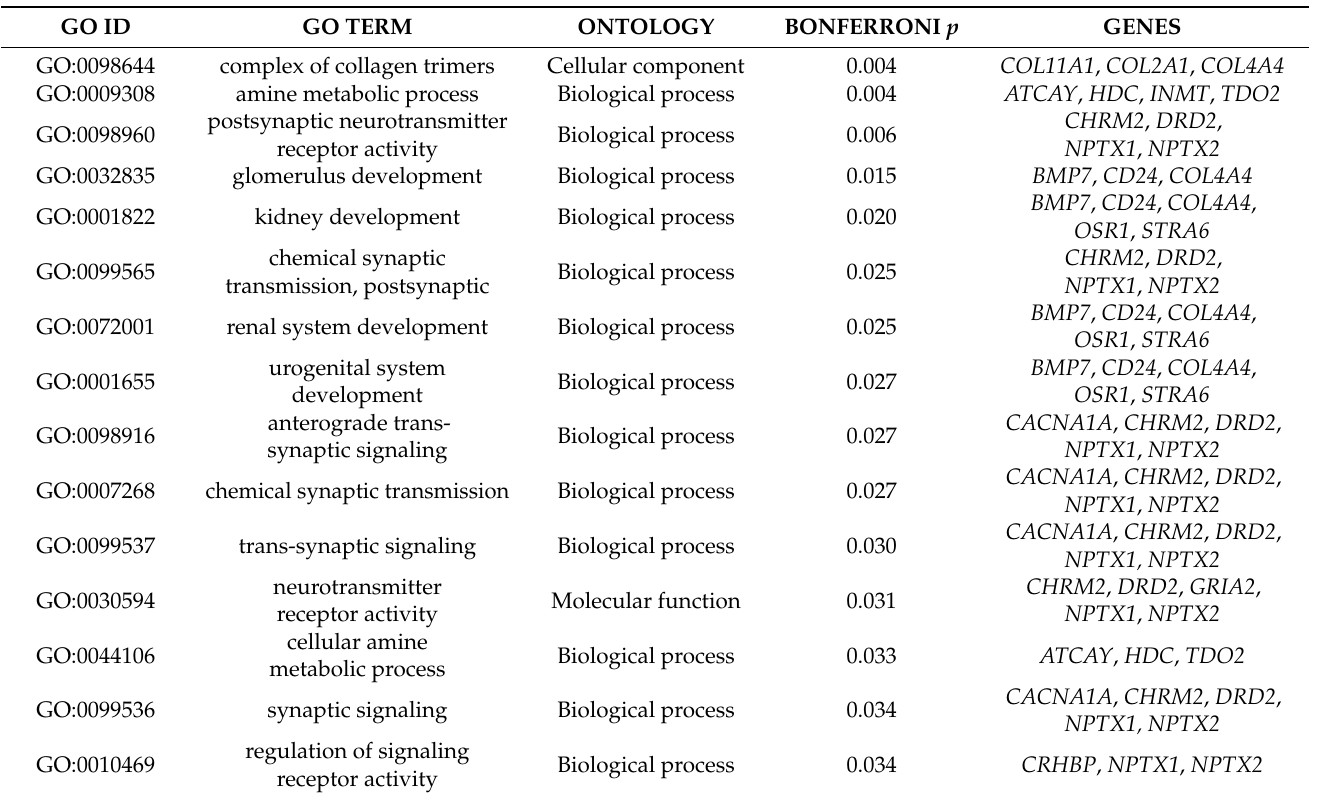
Table 3. Significant GO terms for 204 confirmed genes.